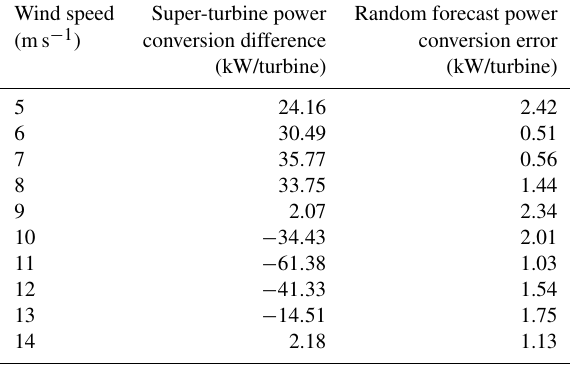
Table 4. Difference of the super-turbine power conversion sub- tracted from the turbine-level power conversion for the hypothetical wind farm of 100 turbines with 1ms − 1 variability simulated 1000 times in the middle column. The MAE of the random forest for each wind speed is shown in the right-hand